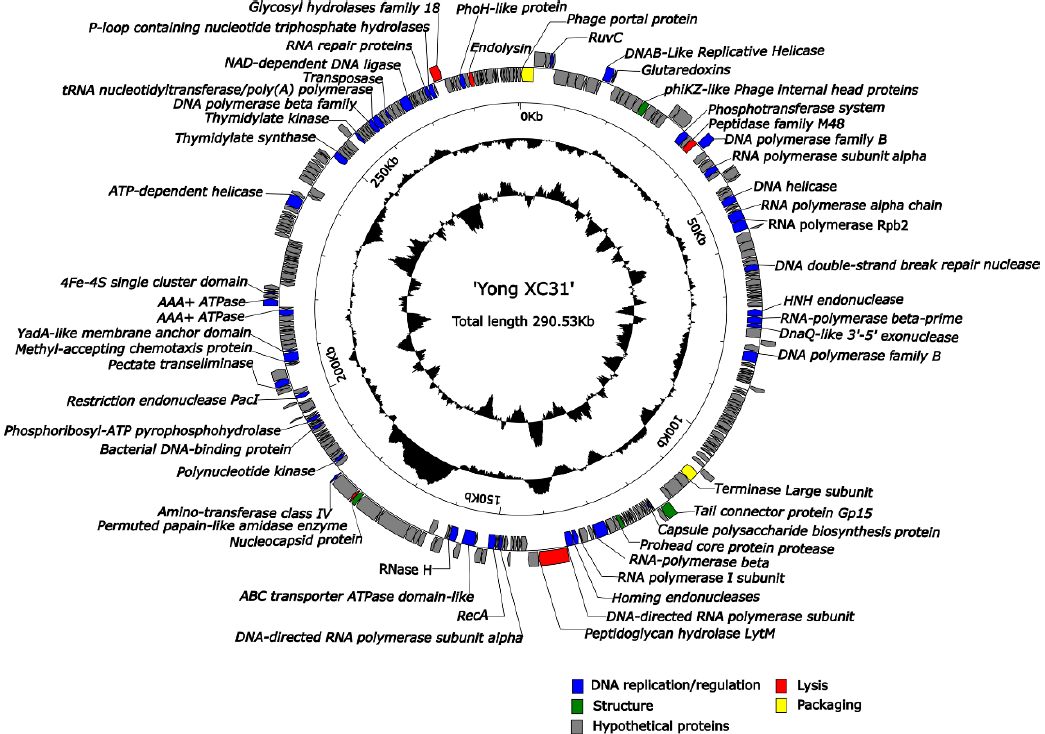
Figure 6. Genome map of Vibrio phage Yong-XC31. The arrow indicates the coding protein sequence, the protein function is distinguished by color, red stands for lysis, yellow for packaging, blue for DNA replication/regulation and green for structure, gray indicates hypothetical protein.